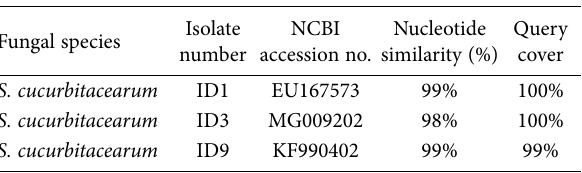
Table 1. Comparison of sequence similarities of Stagonosporopsis cucurbitacearum isolates with sequences already in the NCBI